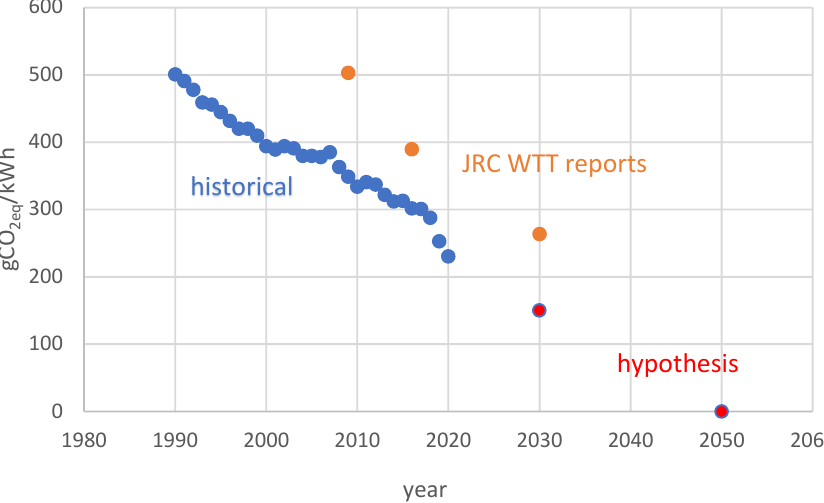
Figure 9. Electricity CO 2eq emissions’ intensity (historical data from EU27 [44], combustion only); JRC WTT reports data [49] (includes both combustion and upstream emissions occurring before the gates of the power plant and resulting from the production and transport of the fuel, infrastructure materials not included); hypothesis assumed for calculations in 2030 and 2050.